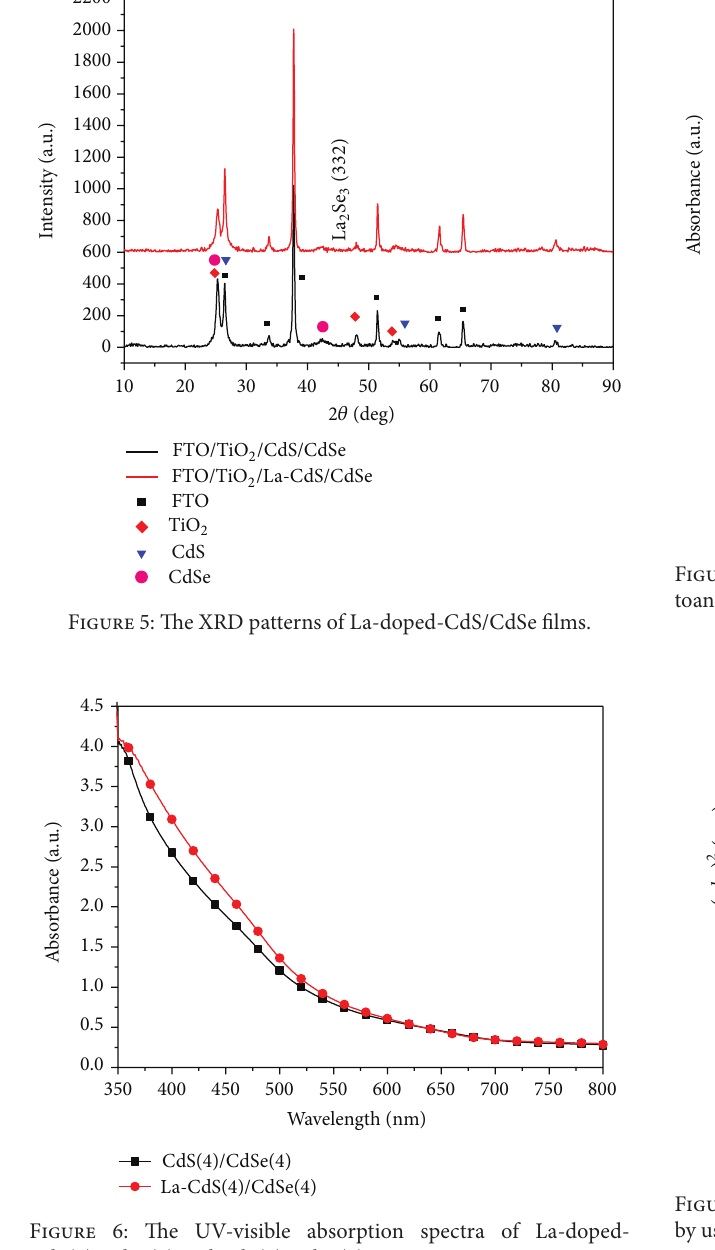
Figure 6: The UV-visible absorption spectra of La-doped- CdS(4)/CdSe(4) and CdS(4)/CdSe(4).